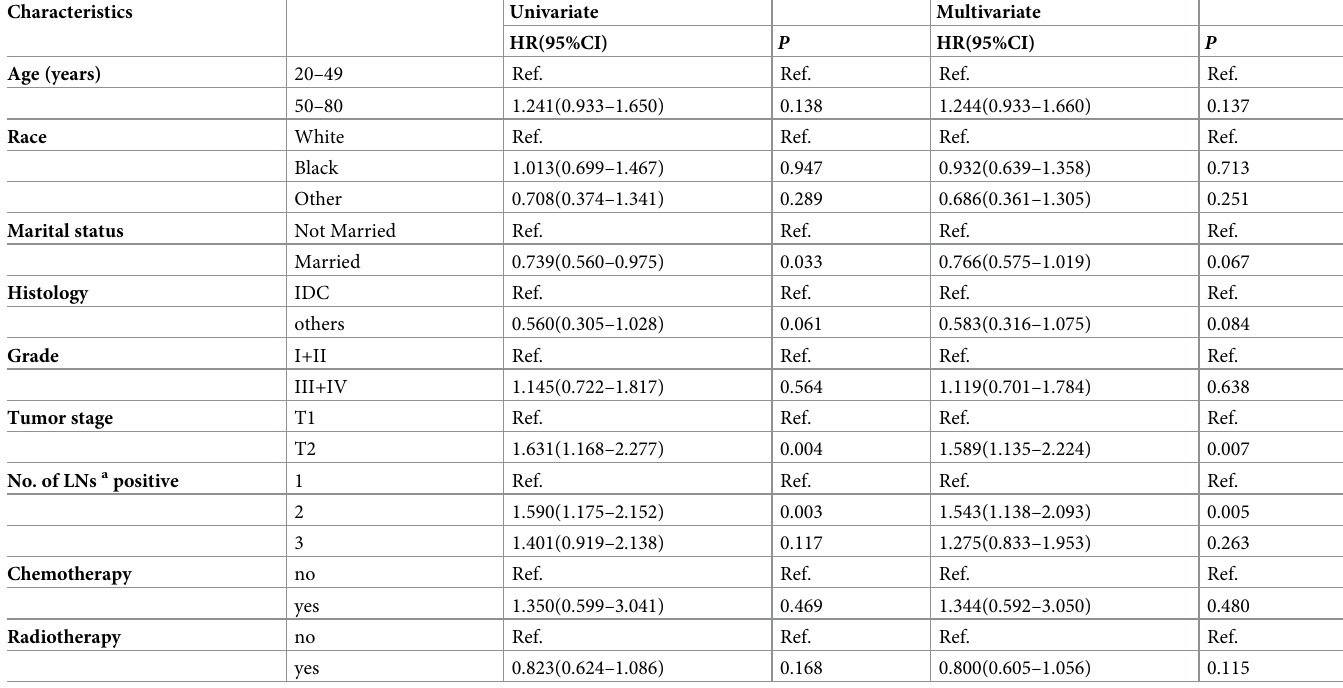
Table 2. Prognostic factors for BCSS in univariate and multivariate